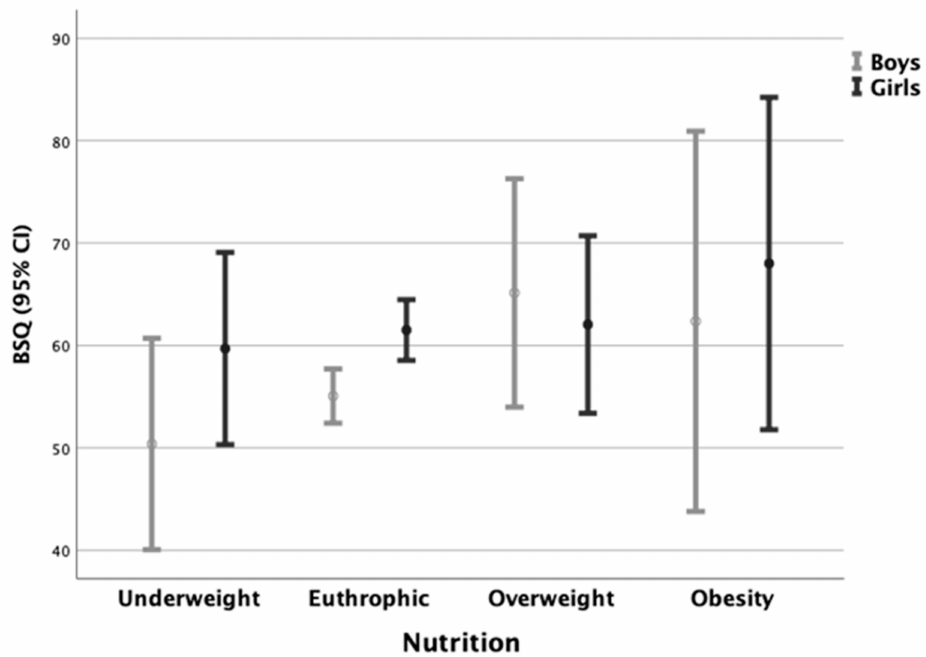
Figure 3. BSQ mean scores according to BMI weight status (Dots = mean values; CI = confidence interval). Using multifactorial analysis including sex, weight status, and adolescence period, only this last variable was related to body self-image dissatisfaction (Wilks’ Lambda: 0.983; p = 0.004). The binary logistic regression model from the odds ratio (OR) risk estimator confirmed that girls (OR:1.19, p = 0.043) and the late adolescence period (OR:1.18, p = 0.012) had a significant association with body